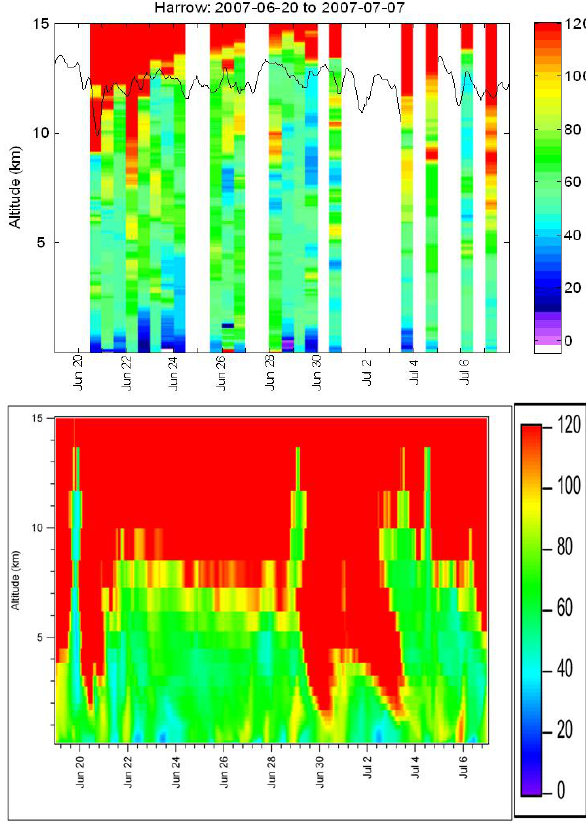
Fig. 4. Comparison of ozone from (a) observations (ozonesondes) and (b) 42km AURAMS Base Case, BAQS-Met Intensive, Harrow